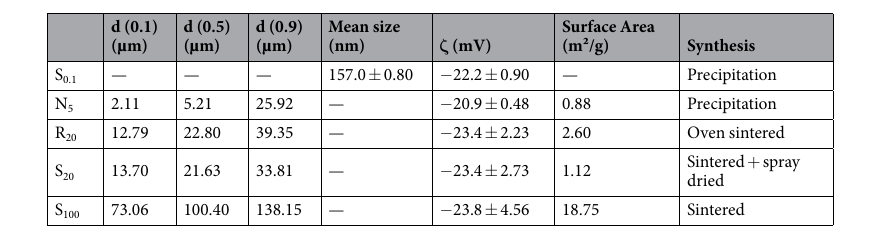
Table 1. Hydroxyapatite particle characterization. Size and zeta potential of HA particles were measured by dynamic light scattering and electrophoretic light scattering, respectively. d (0.1), d (0.5) and d (0.9) indicate that 10 %, 50 % and 90 % of the particles lie below the values